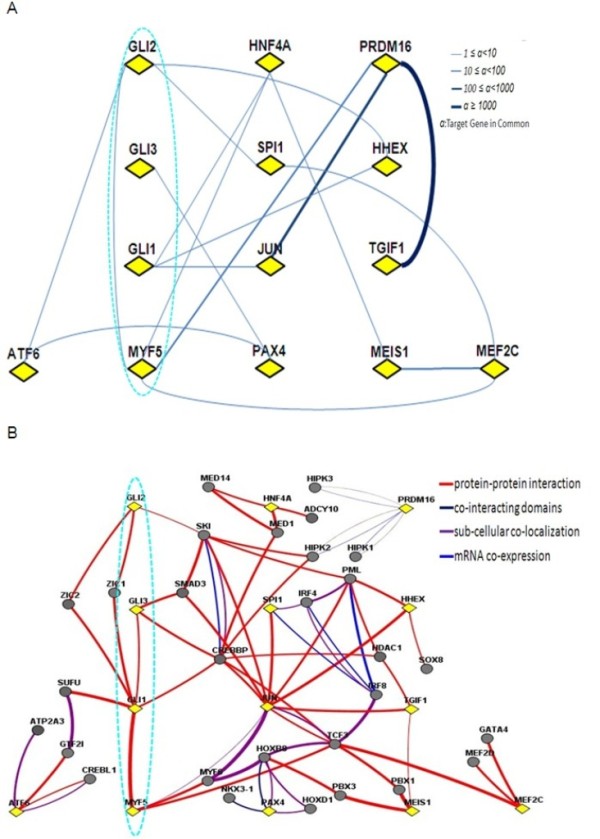
The network linking the GLI transcription factors with MYF5. The network linking GLI family and MYF5 (in dashed ellipse) (A) based on our bovine skeletal muscle dataset and (B) the corresponding network based on human datasets according to FUNCOUP tool [59].